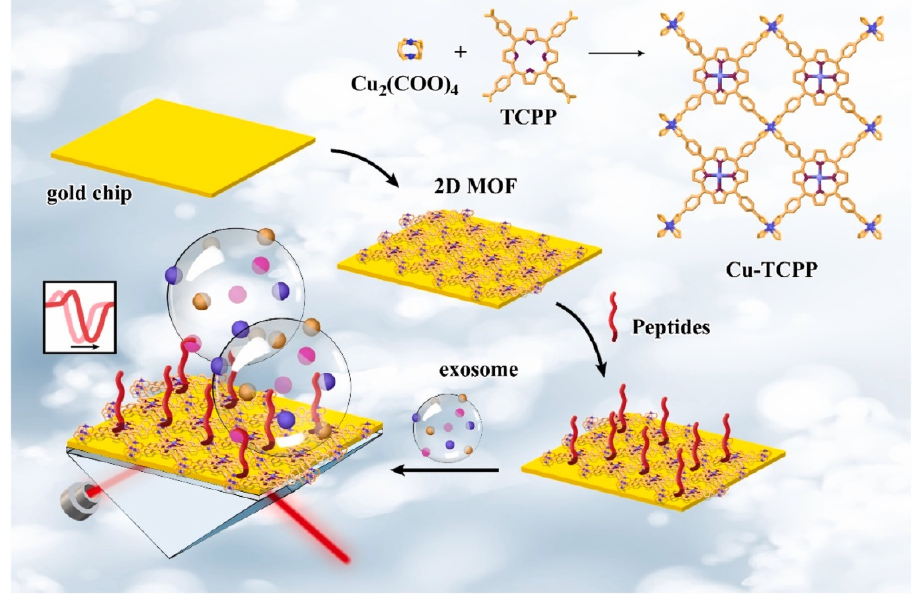
Figure 16. Schematic illustration of a 2D MOF ‐ based surface plasmon resonance biosensor for the detection of PD ‐ L1 exosomes. Reprinted from [125], Copyright (2022), with permission from Elsevier.